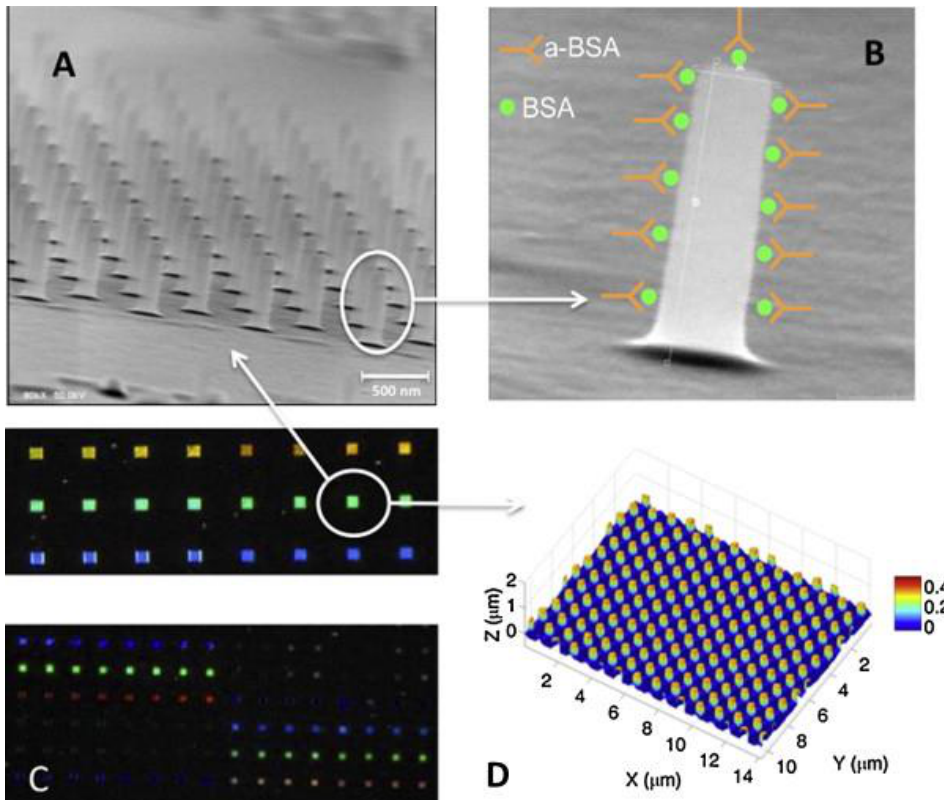
Figure 9. ( A ) SEM micrograph of a SU-8-based BICELL, ( B ) SEM micrograph of one single nano-pillar and a schematic representation of BSA immobilization and aBSA recognition, ( C ) Optical image of a biochip with a number of BICELLs, ( D ) Confocal image (Leica DCM3D) of one of the BICELLs after the infiltration experiments. Reprinted from Holgado et al. [56] with permission of Elsevier.